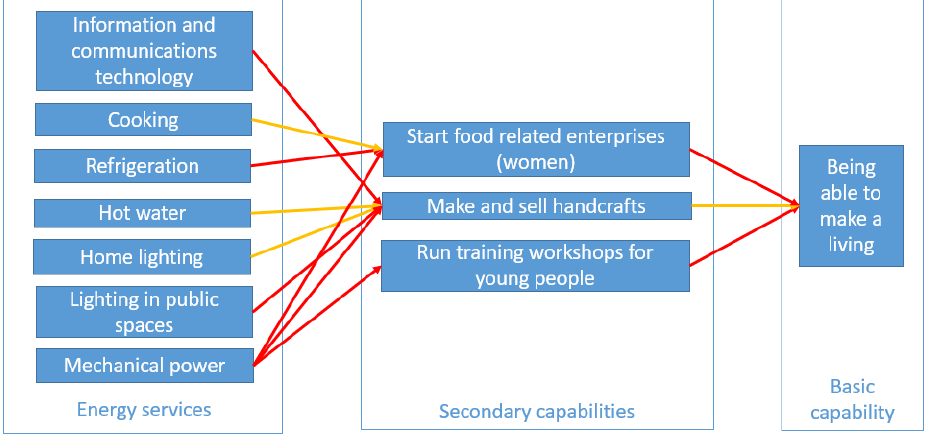
Figure 4. Connections between energy services, secondary capabilities and the ability to make a living.